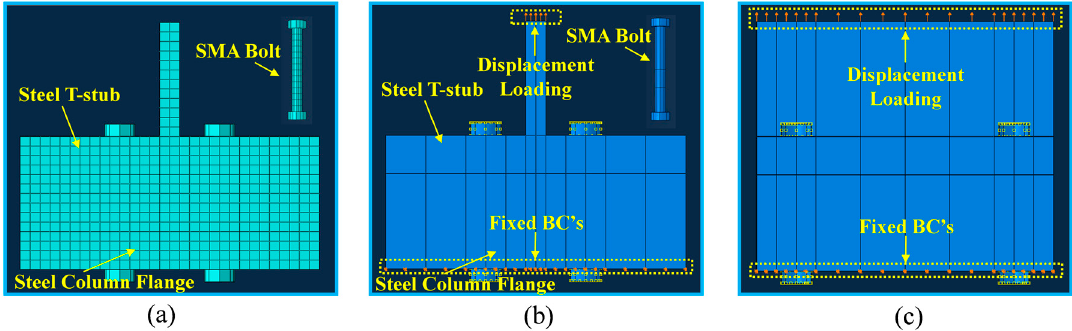
Figure 8. 3D FE (Finite element) models (Case 3 models): ( a ) Element mesh; ( b ) loading and BCs (boundary conditions) of front view; ( c ) loading and BCs (boundary conditions) of side view.